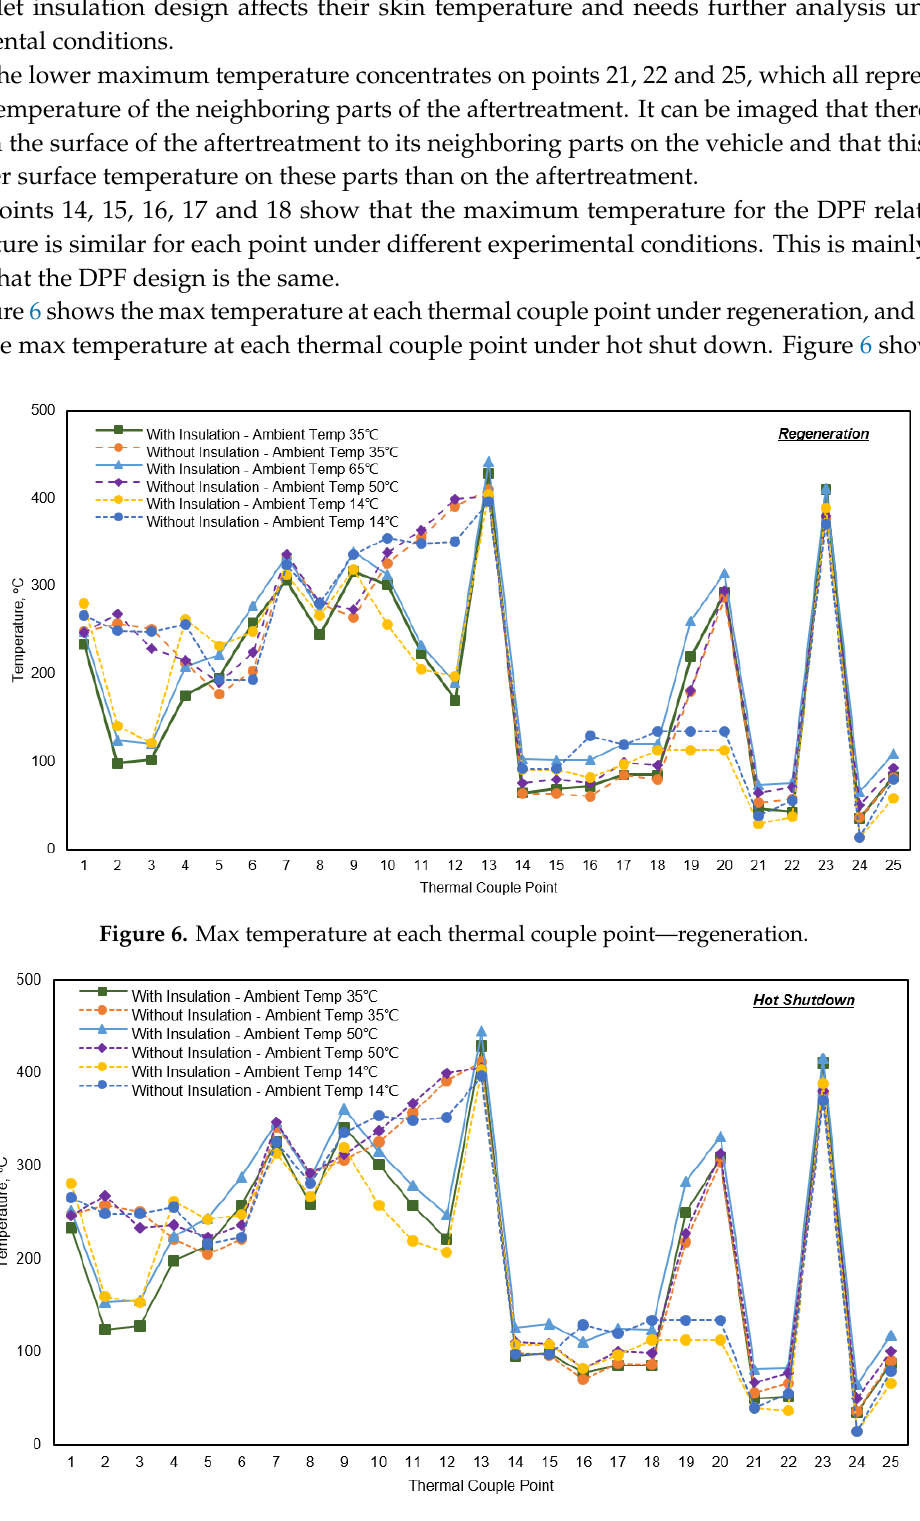
Figure 7. Max temperature at each thermal couple point—hot shutdown